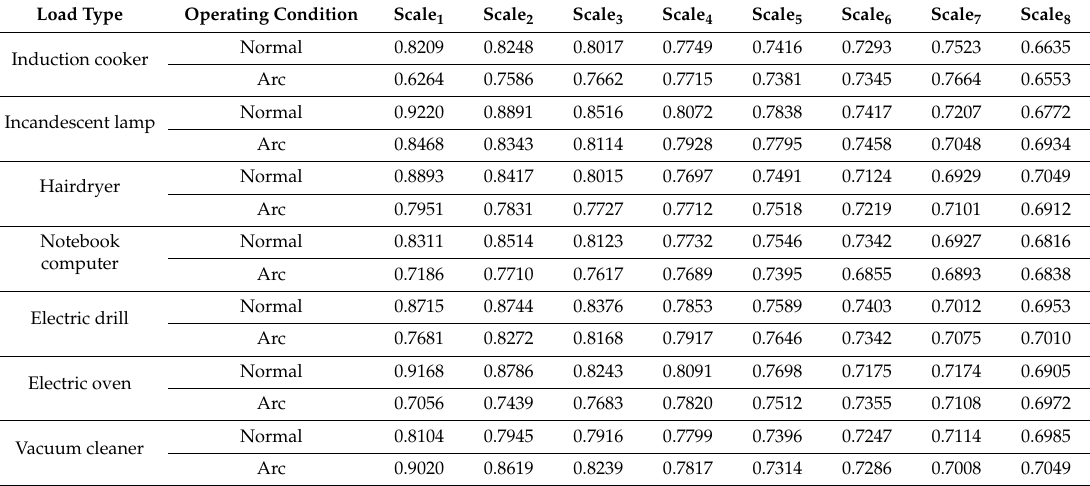
Table 2. The permutation entropy of di ff erent load types during normal operations and serial arc fault